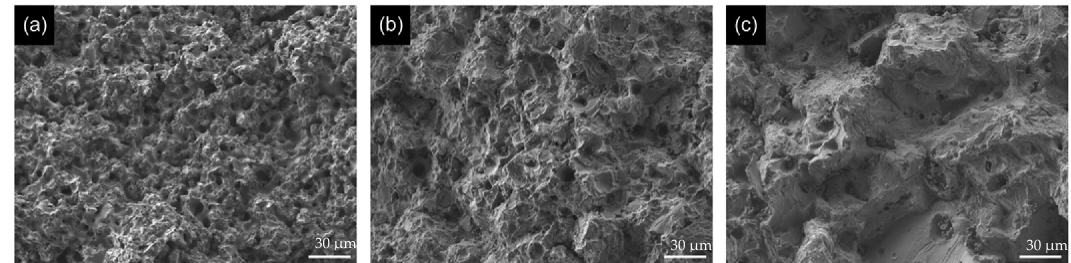
Figure 5. SEM image of the fractured surfaces (after tensile test) of the Co–Cr alloys prepared at three different post-sintering temperatures : ( a ) 1250 °C; ( b ) 1350 °C; ( c ) 1450 °C (500×, scale bar = 30 μ m).